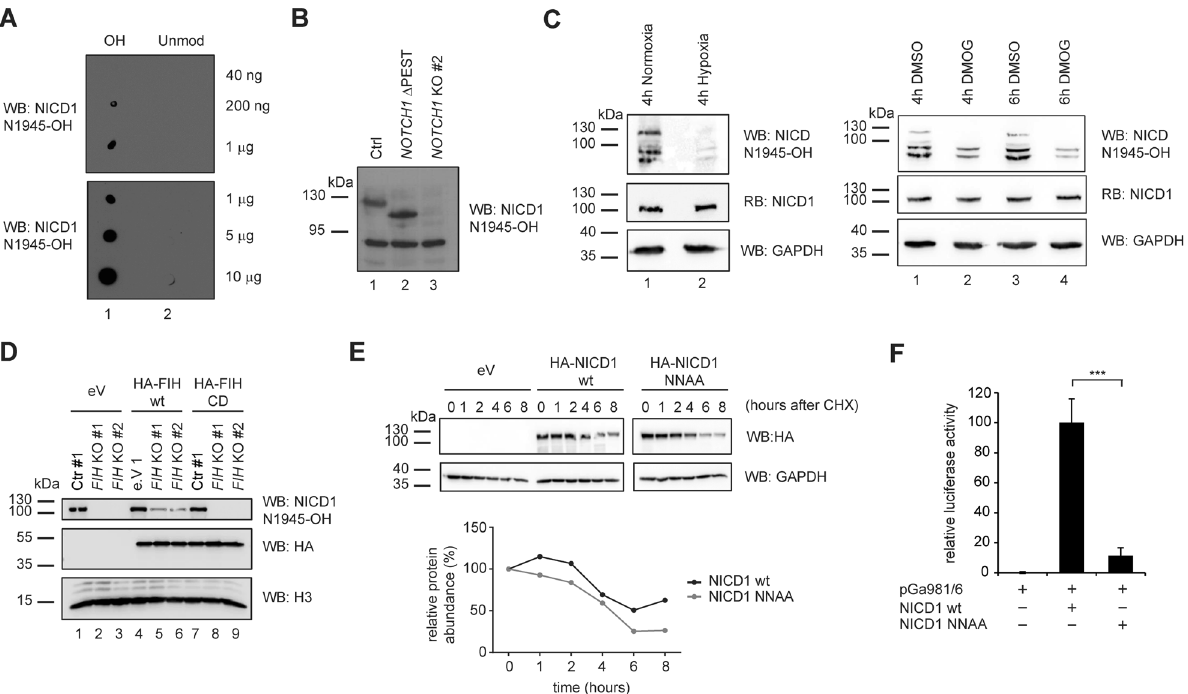
Fig. 3 A hydroxylation-resistant NICD1 mutant has reduced transcriptional activity. A Dot blot showing the speci fi city of the antibody against NICD1 hydroxylated on N1945 (NICD1 N1945-OH). The indicated amounts of NICD1 N1945-OH or unmodi fi ed NICD1 N1945 peptides were pipetted on a nitrocellulose membrane. Membranes were incubated with the NICD1 N1945-OH antibody. B The NICD1 N1945-OH antibody speci fi cally recognizes the NICD1 in HEK 293 cells. Whole-cell extracts (WCE) from HEK 293 cells wild-type (wt), depleted of the NOTCH1 gene ( NOTCH1 KO #2) or of only the sequence encoding for its C-terminal PEST domain ( NOTCH1 Δ PEST) were analyzed by Western blotting (WB) versus NICD1 N1945-OH. C The NICD1 N1945-OH antibody speci fi cally recognizes the NICD1 in Beko cells. Beko cells were kept for (left) 4 h in hypoxia (1% O 2 ) or normoxia (5% O 2 ) as control or, alternatively, treated with (right) 0.5 mM DMOG or with DMSO as a control for 4 or 6 h. WCE were analyzed by WB versus the endogenous NICD1 N1945-OH and reblotted (RB) versus the cleaved NICD1 protein or GAPDH as a loading control. D FIH hydroxylates NICD1 on N1945. HeLa cells depleted of FIH were transfected with plasmids encoding for HA- tagged FIH wild-type (wt), HA-tagged catalytic dead (CD) FIH mutant, or an empty vector as a control (eV). WCE were analyzed by WB versus NICD1 N1945-OH, HA or H3 as a loading control. E NICD1 wild-type is more stable compared to the NICD1 NNAA mutant. Phoenix TM cells were transfected with plasmids encoding for HA-tagged NICD1 wild-type (wt), HA-tagged NICD1 NNAA mutant or an empty vector as a control (eV). Protein synthesis was blocked by adding 150 µg/mL cycloheximide (CHX) and samples were collected at the indicated time points. WCE were analyzed by WB versus HA or GAPDH as a loading control. Quanti fi cation of the NICD1 levels normalized to GAPDH is shown below. The experiment was repeated independently three times. F NICD1 wildtype is more active compared to the NICD1 NNAA mutant. Transactivation capacities of NICD1 wildtype (wt) or NICD1 NNAA mutant was tested in luciferase assays using the RBPJ-dependent reporter construct